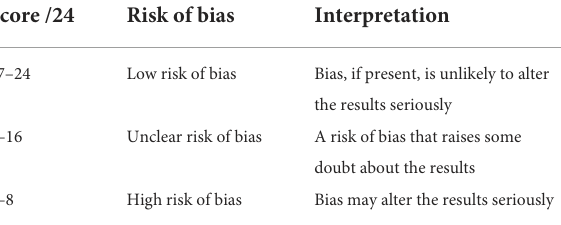
TABLE 7 Adapted risk of bias scoring